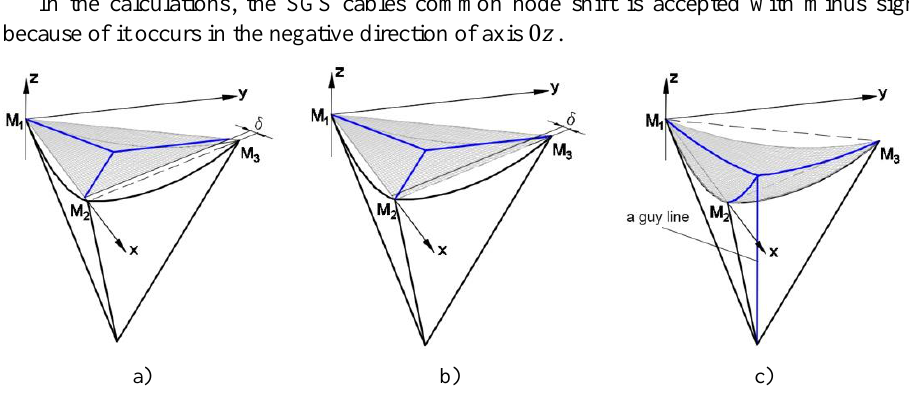
Fig. 18. SGS consisting of three cables coming together at one node